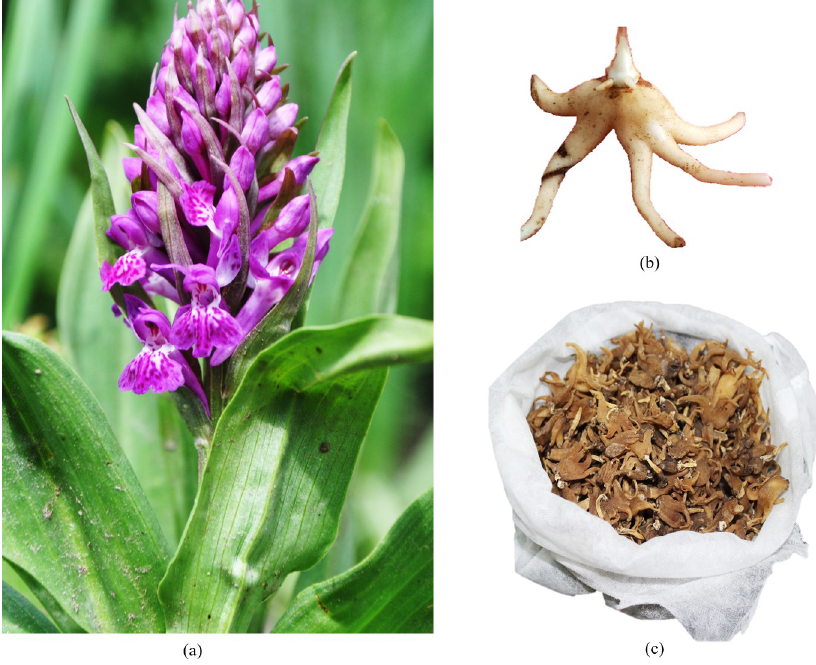
Fig 1. Image showing (a) compact floral structure of D . hatagirea , (b) well developed palmately lobed tuber, and (c) tuber collected and processed as a marketed product.